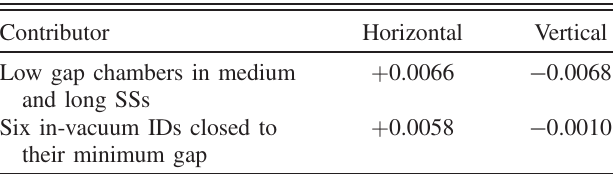
TABLE III. Incoherent tune shifts deduced from the measure- ments at 300